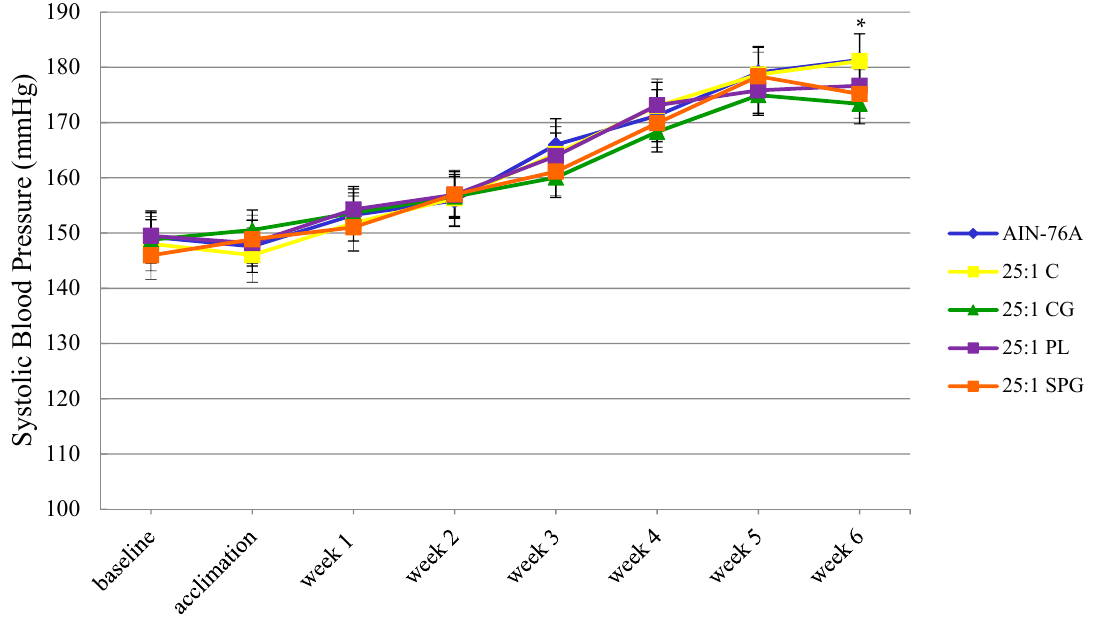
Figure 1. Mean systolic blood pressure of SHRs consuming the AIN-76A diet and diets with a 25:1 ω -6/ ω -3 FAR for 6 weeks. * collard greens diet was statistically different ( p < 0.05) than the AIN-76A and control